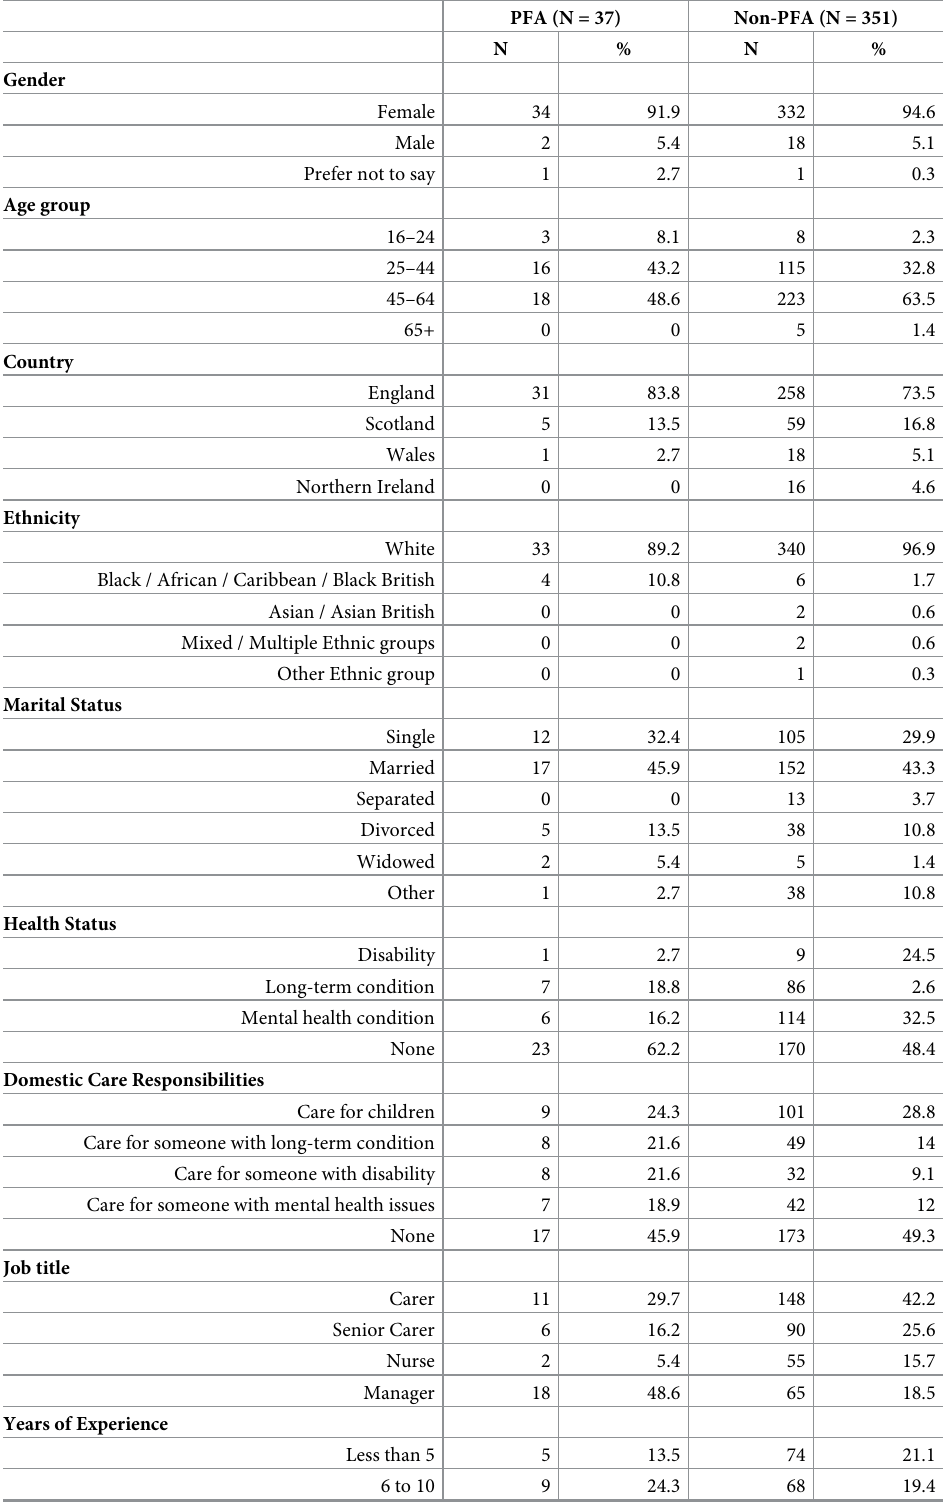
Table 2. Phase 1 demographic